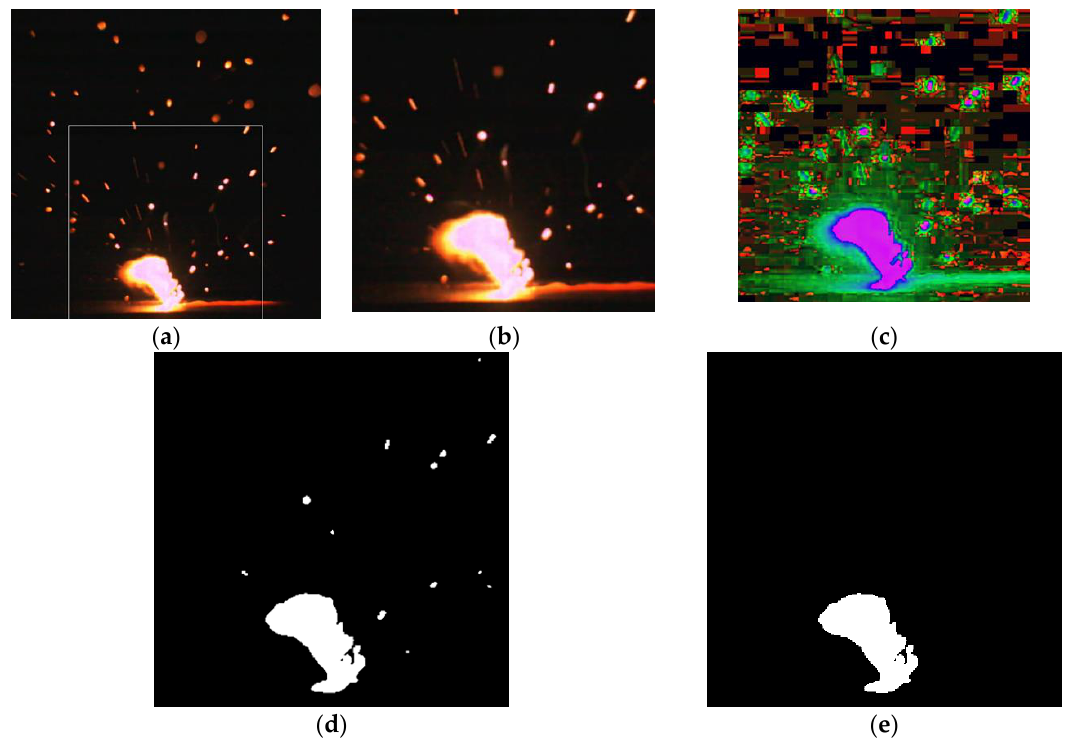
Figure 2. Schematic diagrams of color image processing: ( a ) the original RGB (red, green, blue) image; ( b ) the image has been cut by the white line box in Figure 2a; ( c ) the image has been converted into a HSI (hue, saturation, intensity) image; ( d ) image thresholding has been applied; ( e ) the spatters have been removed.